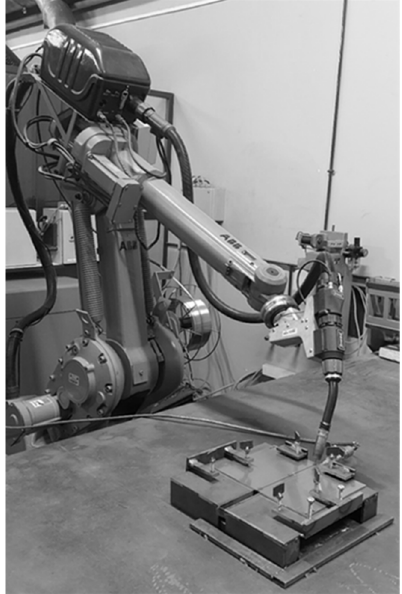
Figure 1. Welding robot and anchoring system.